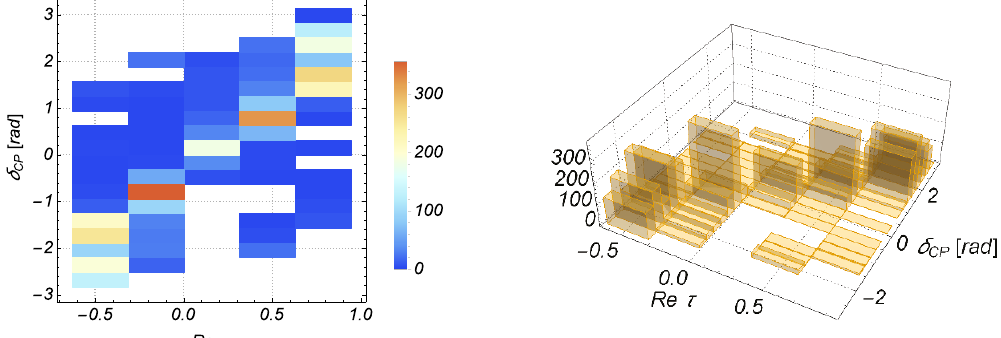
Figure 13 . Distributions of the CP-violating phase δ CP vs. real part of complex structure modulus Re τ for Im τ = 1 . 7 in Pattern IV.